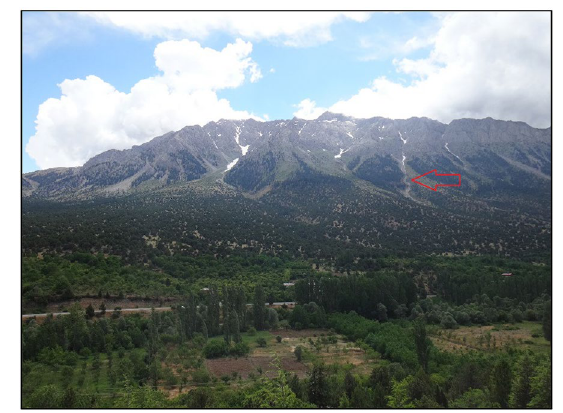
Fig. 6 The mount fronts and avalanche paths in the Ascıbekirli area and its surroundings, which contribute to the geomorphology